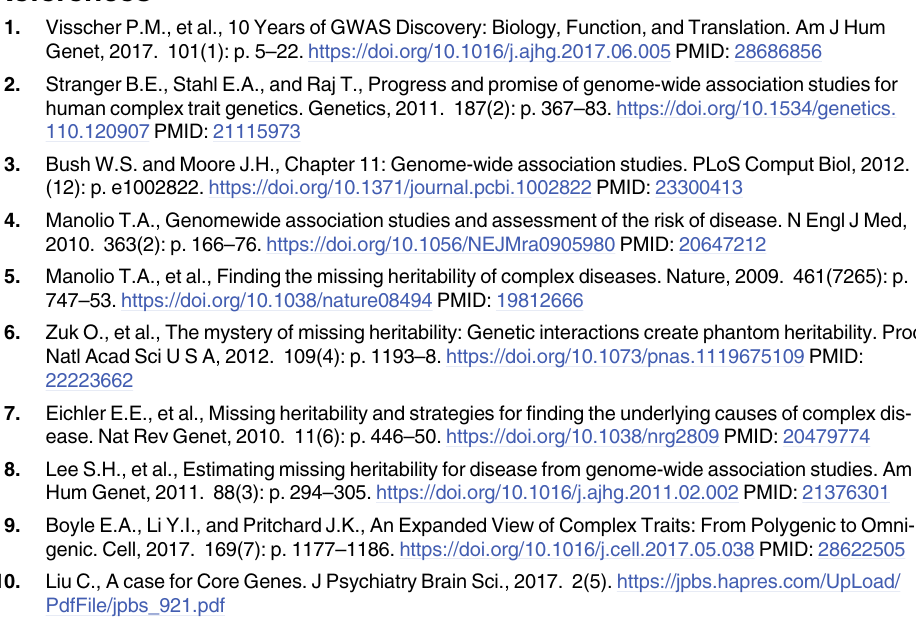
S17 Table. Candidate core genes predicted across different types of networks. Candidate core genes predicted using the 403 Cancer parent term GWAS hits across networks built from different interaction types (Reaction, Catalysis, Activation, Inhibition, Ptmod (post-transla- tional modification), expression and